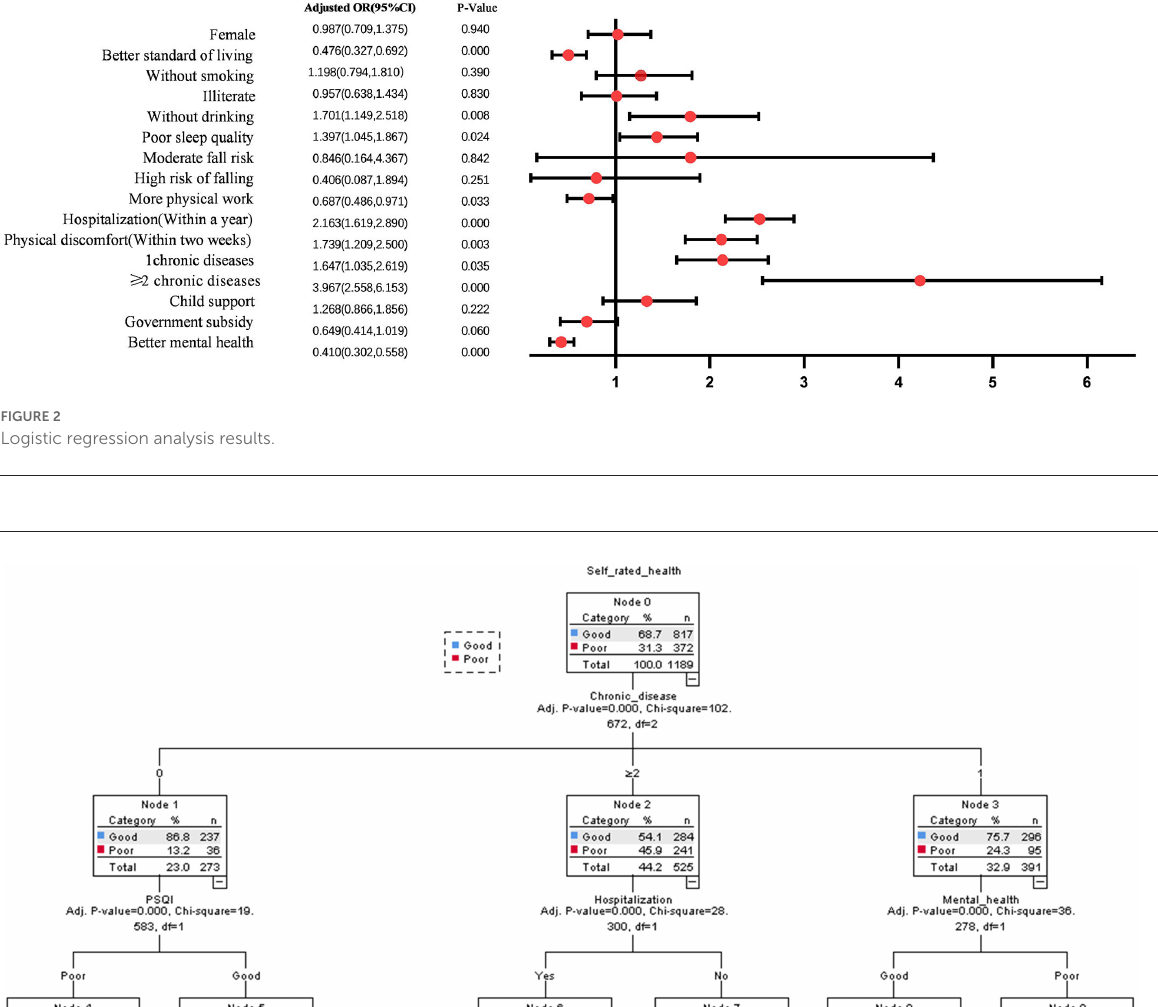
FIGURE3 Classification and regression tree model ( N = 1,189).